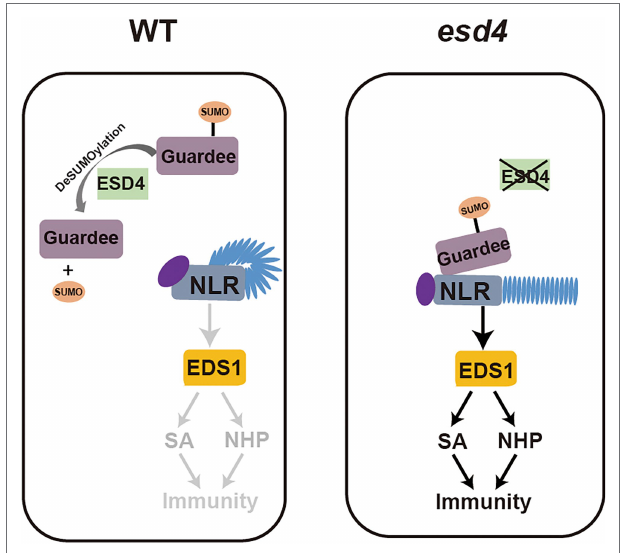
FIGURE 7 | Working model. In wild-type plants, ESD4 deSUMOylates guardee protein to inhibit NLR activation. In esd4 mutants, the SUMOylating status of guardee is sensed by NLR, leading to the activation of downstream immune signaling including SA and NHP